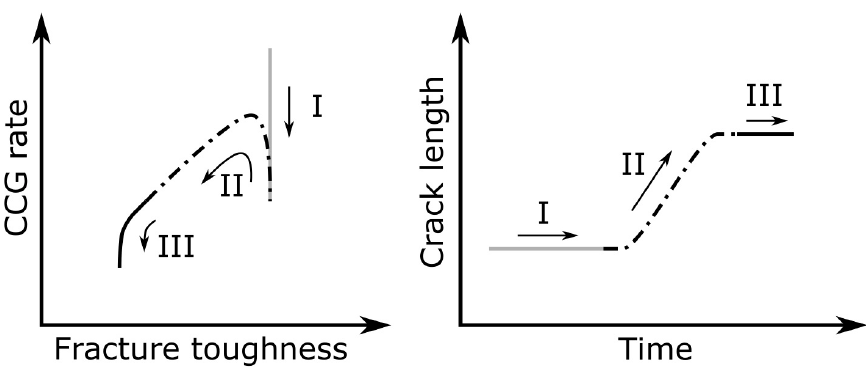
Figure 14. Schematic diagram of the state changes accompanying crack growth due to the creep immersion.